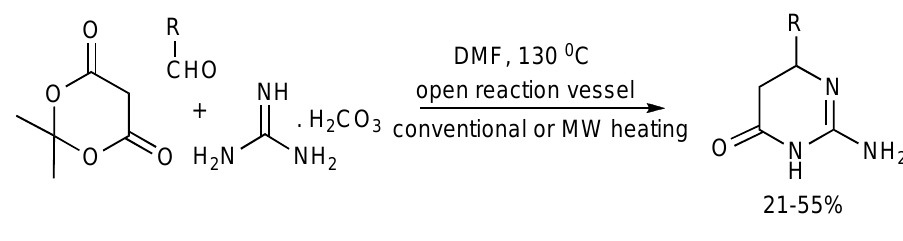
21-55%open reaction vessel conventional or MW heating